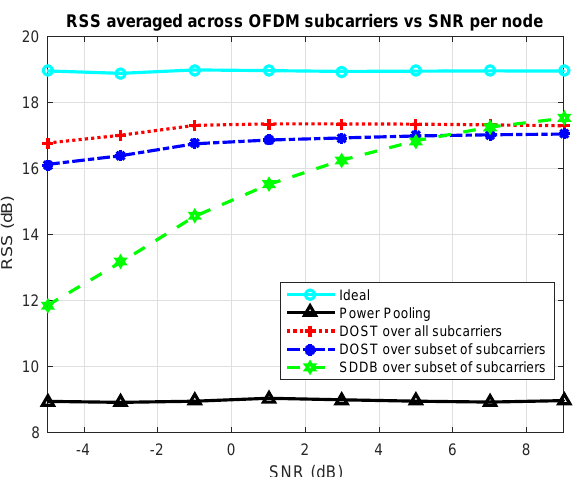
Figure 7. Received signal strength averaged over OFDM subcarriers vs. SNR per node for N = 10